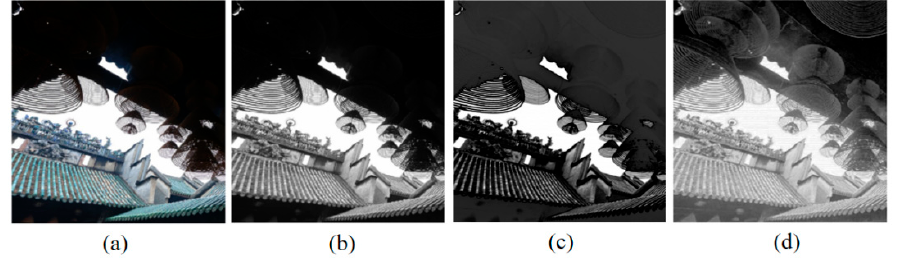
Figure 5. Results of biological vision model and FT model. ( a ) Original RGB image; ( b ) grayscale image of the original image; ( c ) grayscale image processed by FT model; ( d ) the grayscale image processed by biological vision model.